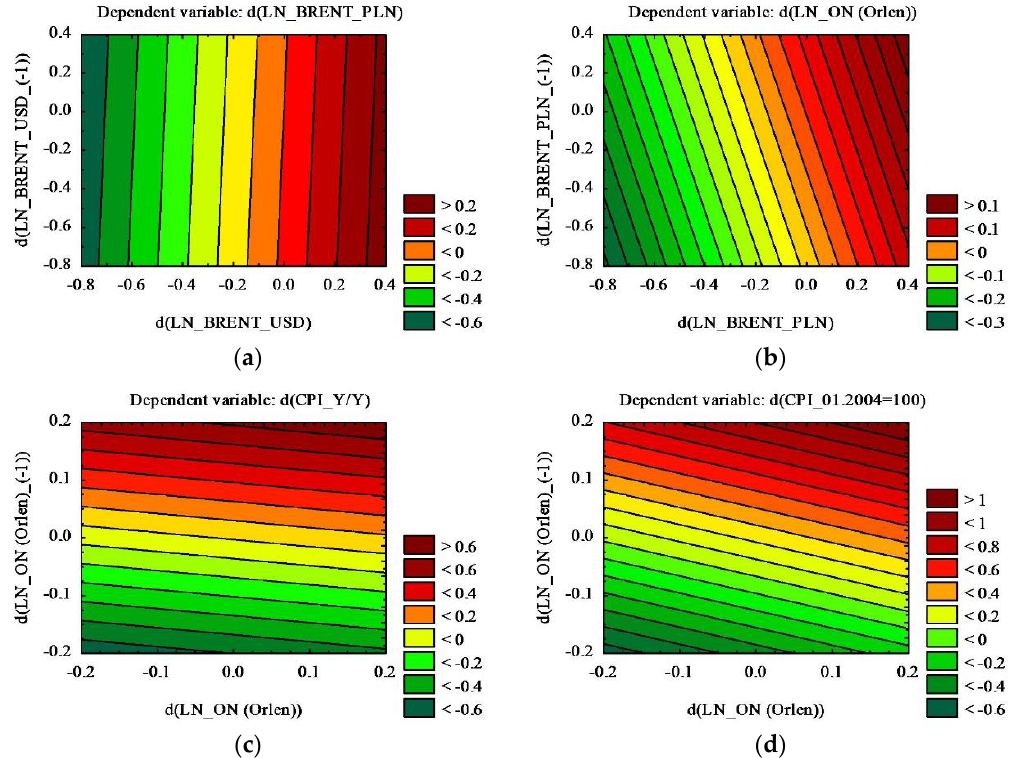
Figure 4. Dependencies taking into account time shifts. ( a ) Crude oil price response (in PLN) to changes in crude oil prices in the world markets; ( b ) Diesel oil prices response to changes in crude oil prices (in PLN); ( c ) Inflation (CPI_Y/Y) response to changes in diesel oil prices; ( d ) Inflation (CPI_01.2004 = 100) response to changes in diesel oil